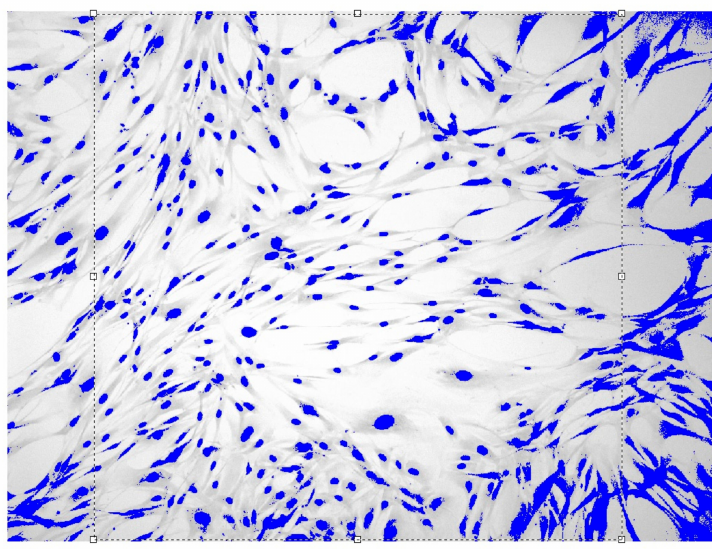
Figure 2. Fibroblasts E = 500 J, t = three days, D = 1.571 ± 0.034 Sudan IV and hematoxylin-eosin staining, magnification n =